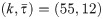
Spatial patterns of functional connectivity with respect to task-positive and task-negative networks.(A) Long-timescale functional connectivity of the modeled and empirical data (top: model; bottom: empirical). The modeled connectivity was averaged over 100 samples simulated with the parameter set (k,τ¯)=(55,12). The empirical connectivity was averaged over 84 subjects. The black thick square lines in connectivity matrices indicate a partition dissociating task-negative (CON, DMN, LMN) and task-positive (DAN, VAN, SMN, VIS) networks. (B) The similarity of modeled and empirical centroids of time-resolved functional connectivity during each network state. The similarity was assessed between modeled centroids in each simulation sample and empirical centroids averaged over subjects. The similarity was quantified by the correlation coefficient of centroid’s functional connectivity weights over edges with direct structural connections. (C) Between-state differences in centroid’s functional connectivity weights (left: segregated state minus integrated state; right: high modularity period minus low modularity period; top: model; bottom: empirical). The between-state differences of weights were averaged within each pair of the seven network components in [50] and are presented in the matrices as t-scores if they were significant (p < 0.05, FDR corrected). The yellow square lines show the partition separating task-negative and task-positive networks.